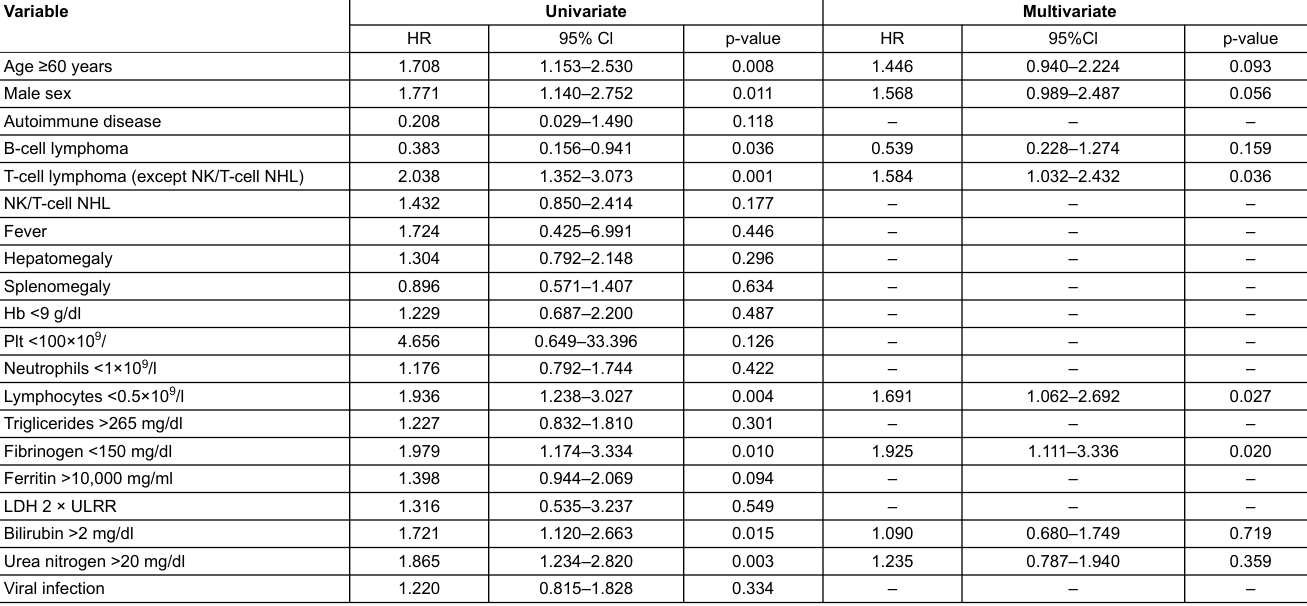
Table 3: Univariate and multivariate analysis of HLH